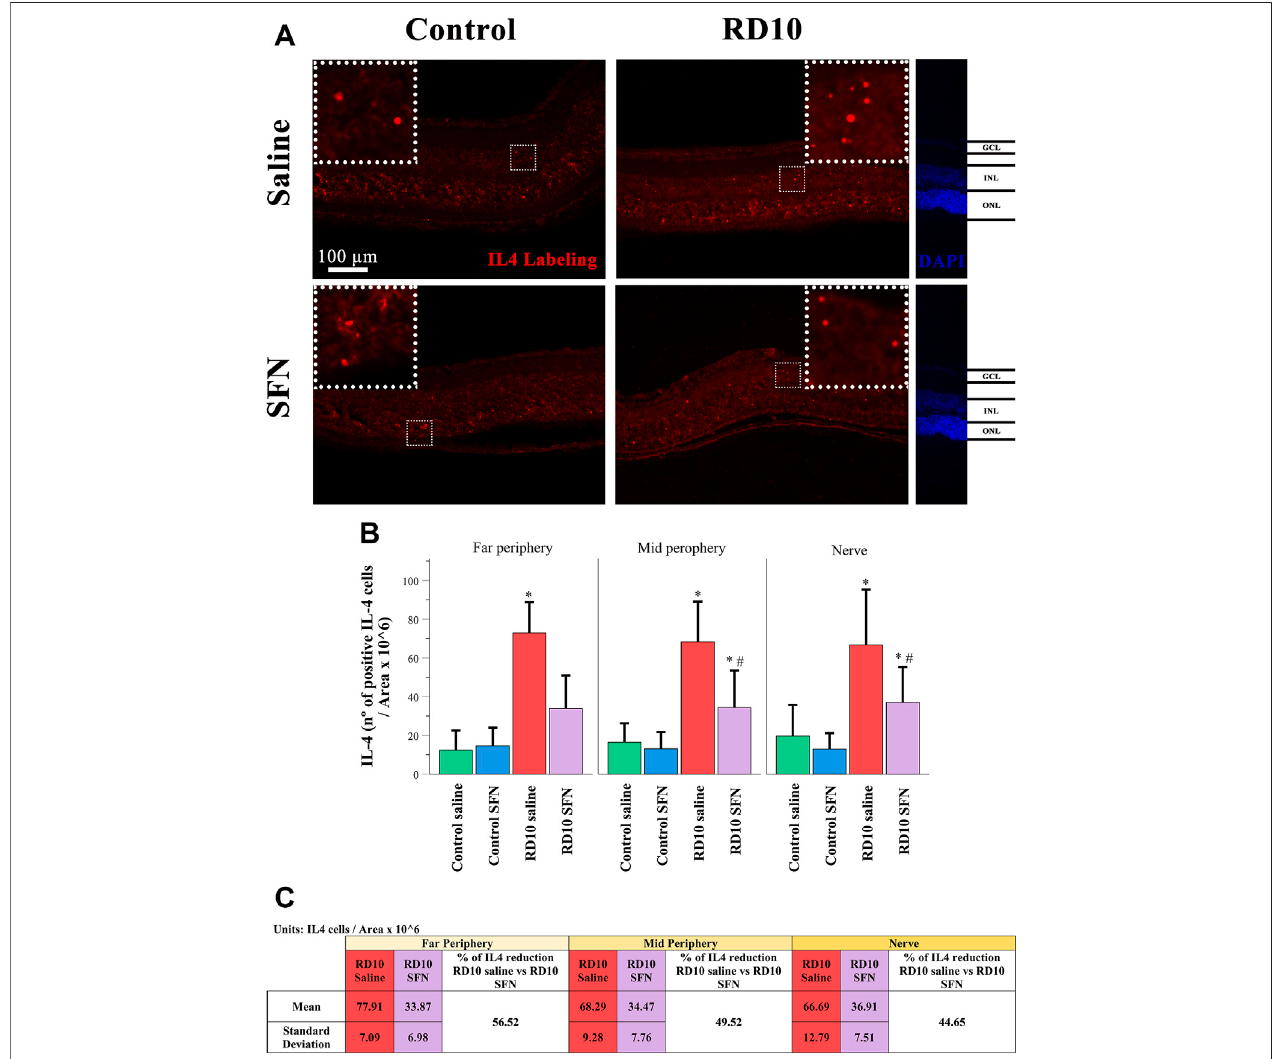
FIGURE9| IL-4expression assessment. (A) NerveregionimagesofIL-4immuno fl uorescenceofthedifferentgroupsintheexperiment; whitearrows pointoutthe positive mark. (B) The number of IL-4-positive cells was divided per area and multiplied by 10 6 . *Differences between Control Saline vs. RD10 Saline or Control SFN vs. RD10 SFN ( p -value < 0.05). #Differences between RD10 Saline vs. RD10 SFN ( p -value < 0.05). (C) Effect of SFN on RD10 mice IL4 mark expressed by the mean and standard deviation of the RD10 groups, and percentage reduction of RD10 Saline vs. RD10 SFN.